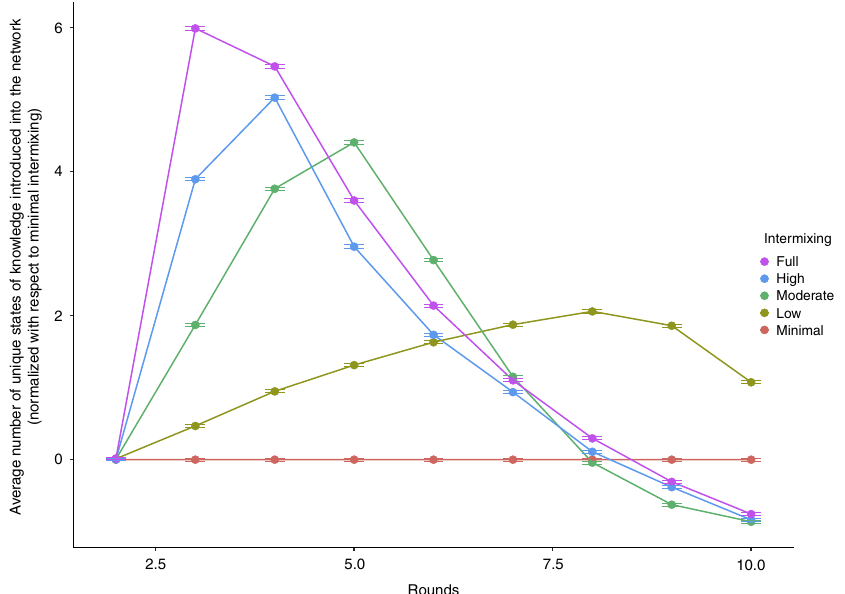
Fig. 5 Unique knowledge produced by diverse ability intermixing. The average marginal number of unique states of knowledge over time for the diversity of ability simulations — as compared to the number of unique solutions generated by minimal intermixing networks — by intermixing rate. Error bars are the standard errors measured across NK